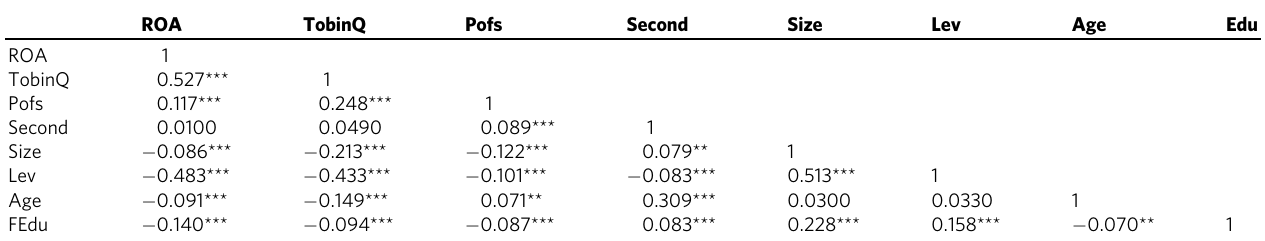
Table 5 Correlation analysis of variables.